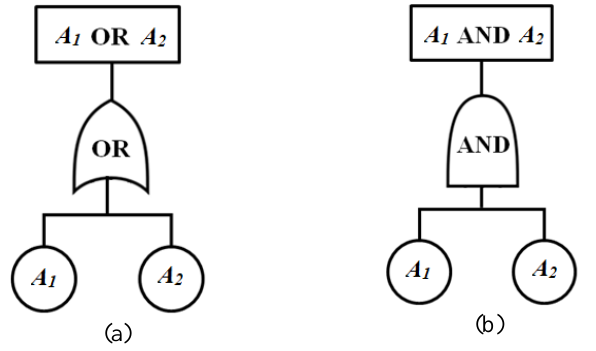
Figure 2. Fault trees for series (a) and parallel (b)